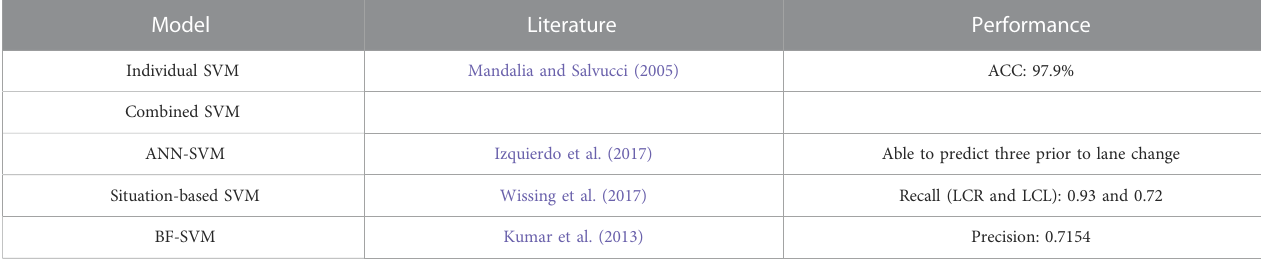
TABLE 6 Summary of SVM-based models for lane-changing